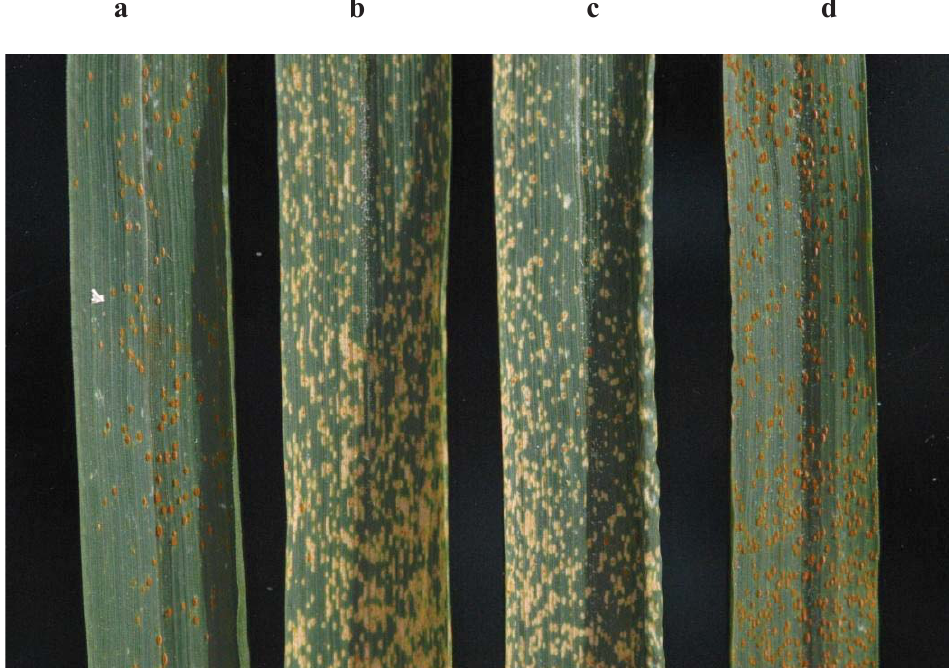
Figure 6. Flag leaves of Thatcher wheat lines expressing resistance to Puccinia triticina ( a ) Thatcher+ Lr34 ( b ) Thatcher+ Lr12 ( c ) Thatcher+ Lr13 ( d ) Thatcher. Photo